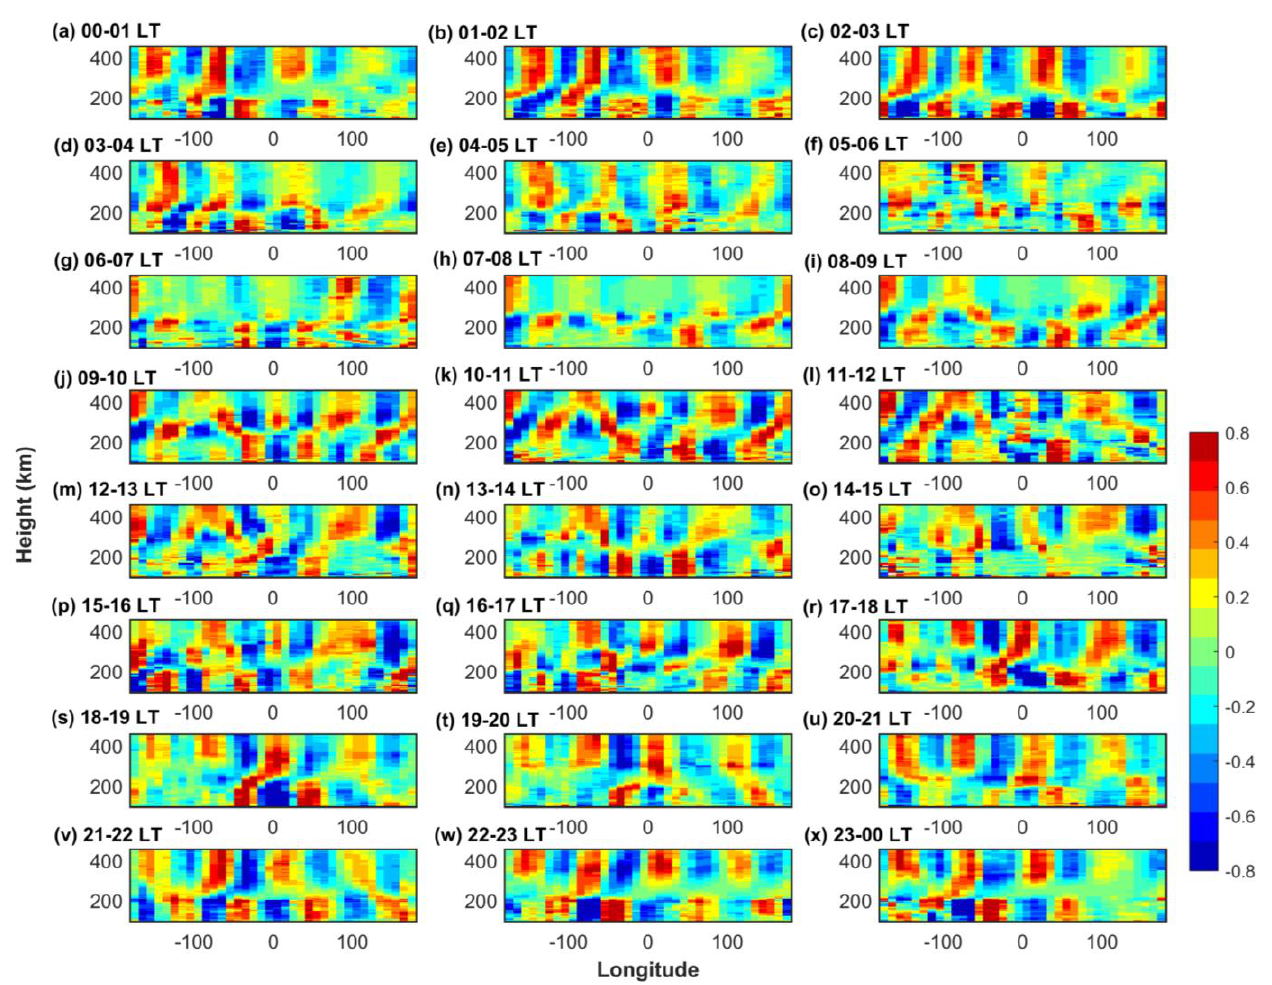
Figure 4. Hourly maps of altitude – longitude variation of WN4-filtered (residual) component of nor- malized electron density for September 2020. Panels ( a – x ) represent hourly epoch from 00 – 01 LT to 23 – 00 LT.